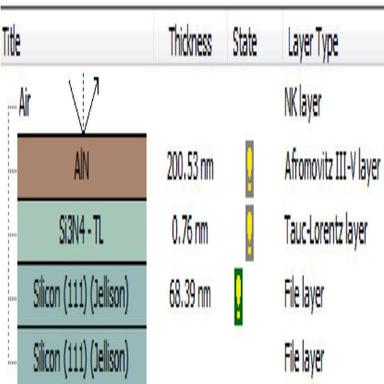
Layer wise model of the layers associated to the device under test.